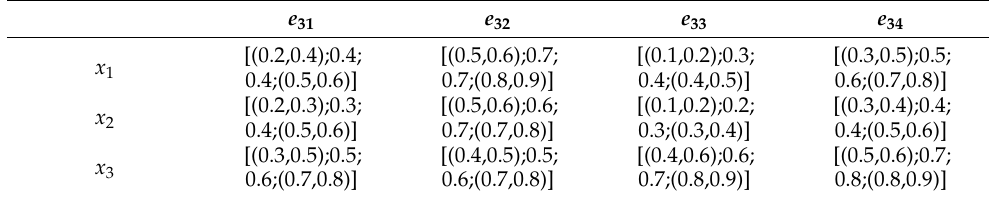
Table A8. The different risk evaluation values subordinated by influencing factors of B 3 at time t 2 .